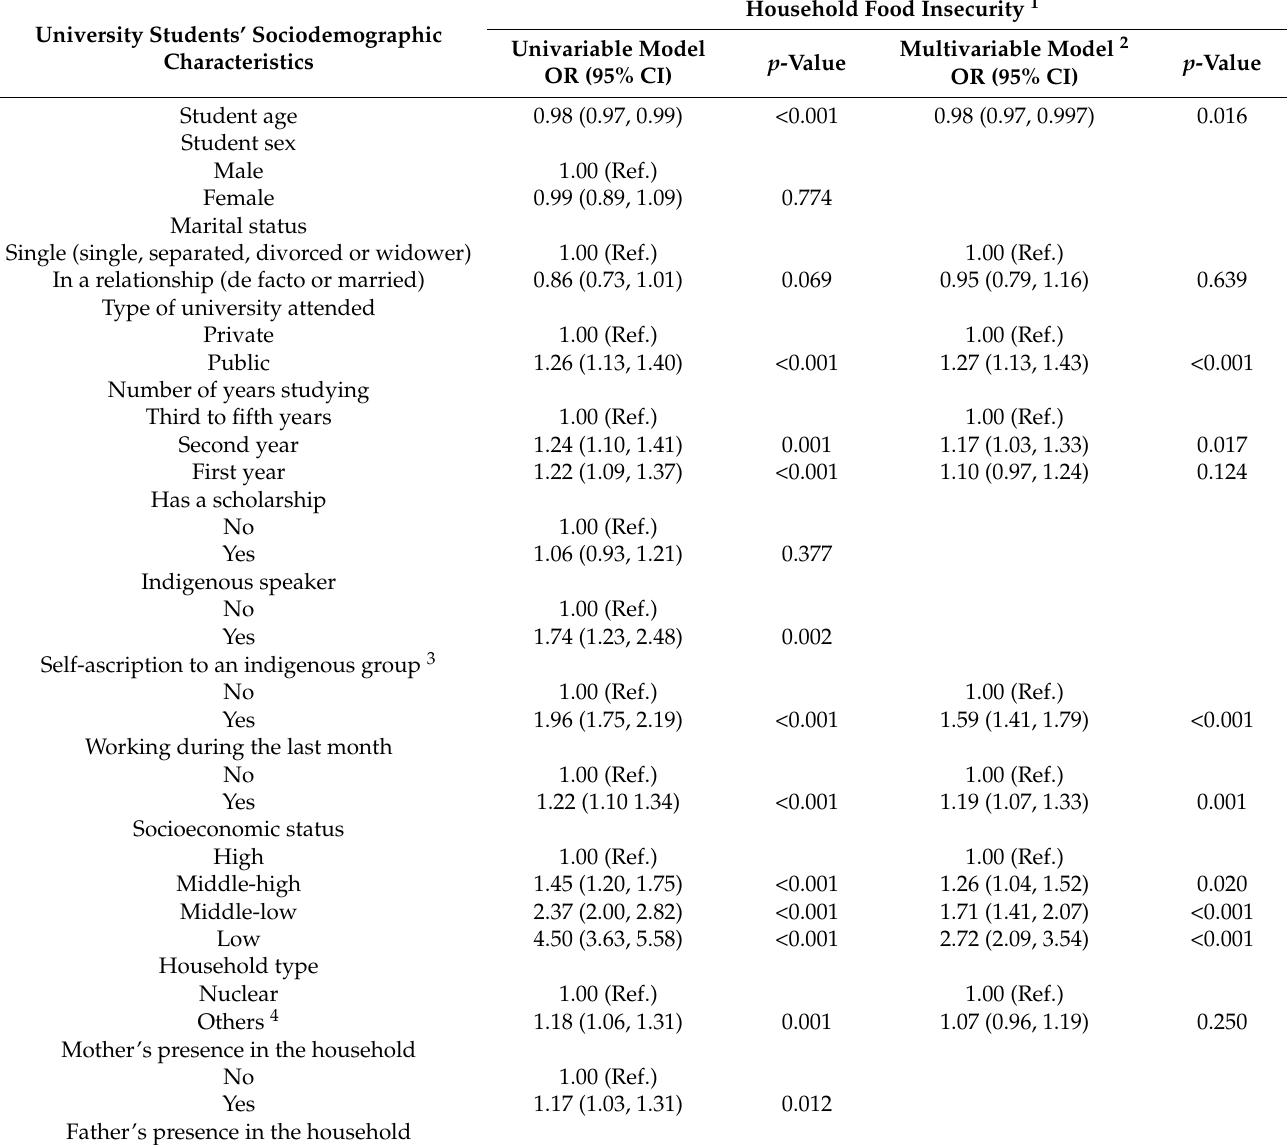
Table 2. Univariable and multivariable logistic regression models of sociodemographic characteristics associated with household food